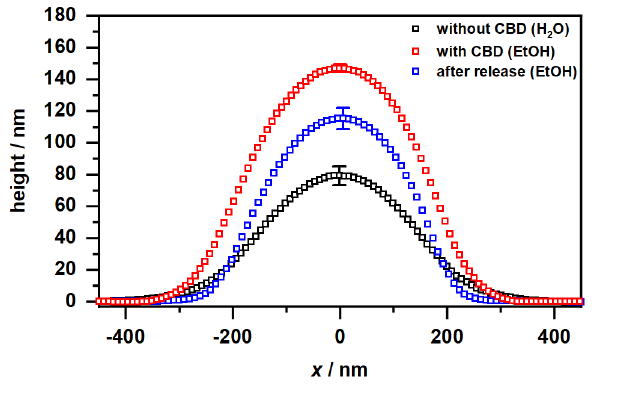
Figure 11. Height profiles of the copolymer microgel particles cast from water (black), after CBD incorporation deposited from EtOH (red) and after CBD release and again cast from EtOH (blue), obtained by AFM measurements in the completely dry state after the deposition of the copolymer microgel particles on a PEI coated silicon surface. All height profiles were generated by averaging the individual height images of at least 50 particles. The error bar indicates the statistical uncertainty of the